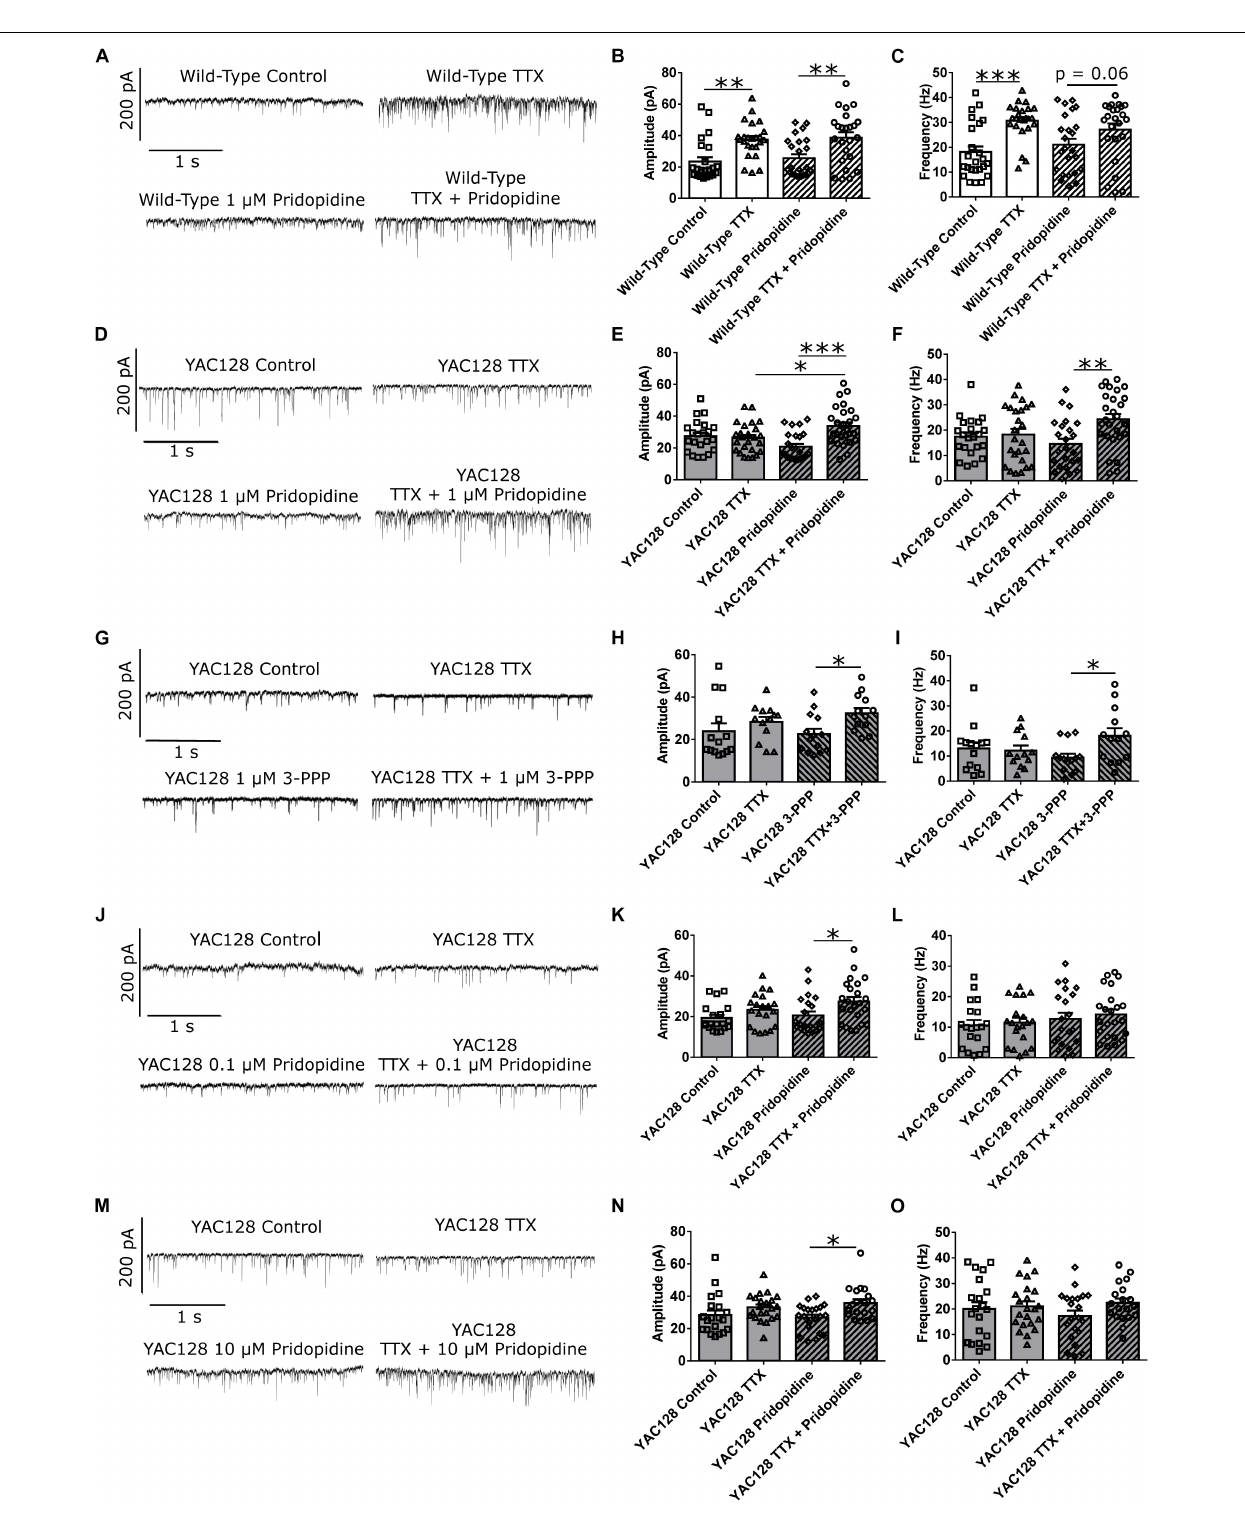
FIGURE 4 | Pridopidine and S1R agonist 3-PPP both restore homeostatic plasticity at a 1 µ M concentration. (A) Representative traces of mEPSC recordings from WT CPNs treated with TTX and/or 1 µ M pridopidine. (B) mEPSC amplitude of WT CPNs treated with TTX and/or 1 µ M pridopidine. Cells treated with only TTX had larger mEPSCs than those treated with only vehicle control ( ∗∗ p < 0.01, Bonferroni post hoc t -test), and cells treated with TTX and pridopidine had larger mEPSCs than those treated with only pridopidine ( ∗∗ p < 0.01, Bonferroni post hoc t -test; TTX p < 0.001, two-way ANOVA). (C) mEPSC frequency of WT CPNs treated